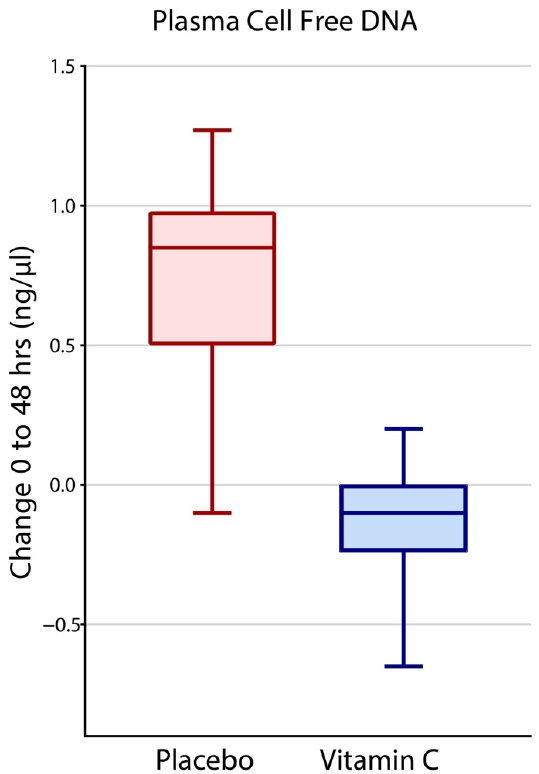
Figure 1. Forty-eight-hour change in cell-free DNA (cfDNA) in the two groups, Placebo and HDIVC. Median values, the top and bottom of the boxes show the interquartile range (IQR), whiskers show 95% CI. Outliers outside the 95% confidence intervals were graphically omitted. 3.3. Effects of Intravenous Vitamin C on Plasma Syndecan-1 Mean baseline syndecan-1 levels in HDIVC and placebo arms were 9.49 ng/mL (SD 5.57 ng/mL) and 10.83 ng/mL (SD 5.95 ng/mL), respectively, with no statistical difference ( p = 0.14). At 48 h, syndecan-1 levels in HDIVC subjects increased to 10.43 ng/mL (SD 6.05 ng/mL) while corresponding levels in placebo subjects increased to 11.22 ng/mL (SD 5.31 ng/mL). The change in placebo subjects at 48 h (1.53 ng/mL, 95% CI, 0.96 to 2.11) was twice that of HDIVC subjects (0.75 ng/mL, 95% CI, 0.21 to 1.29, p = 0.05). (Figure 2).